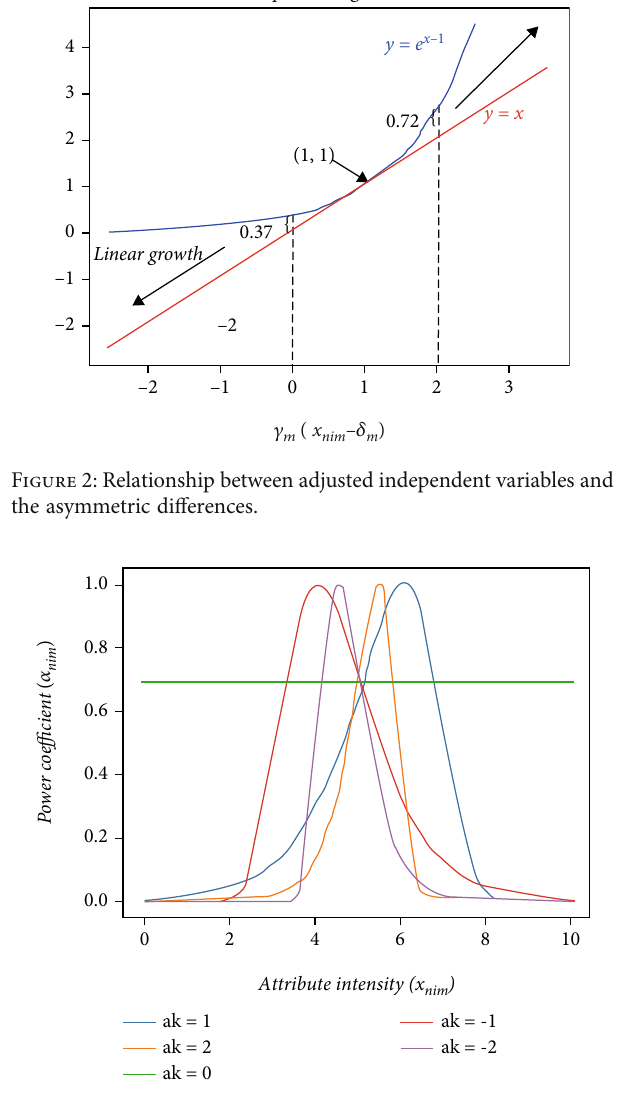
Figure 3: Relationship between power coe ffi cient and attribute intensity with the variation of scale